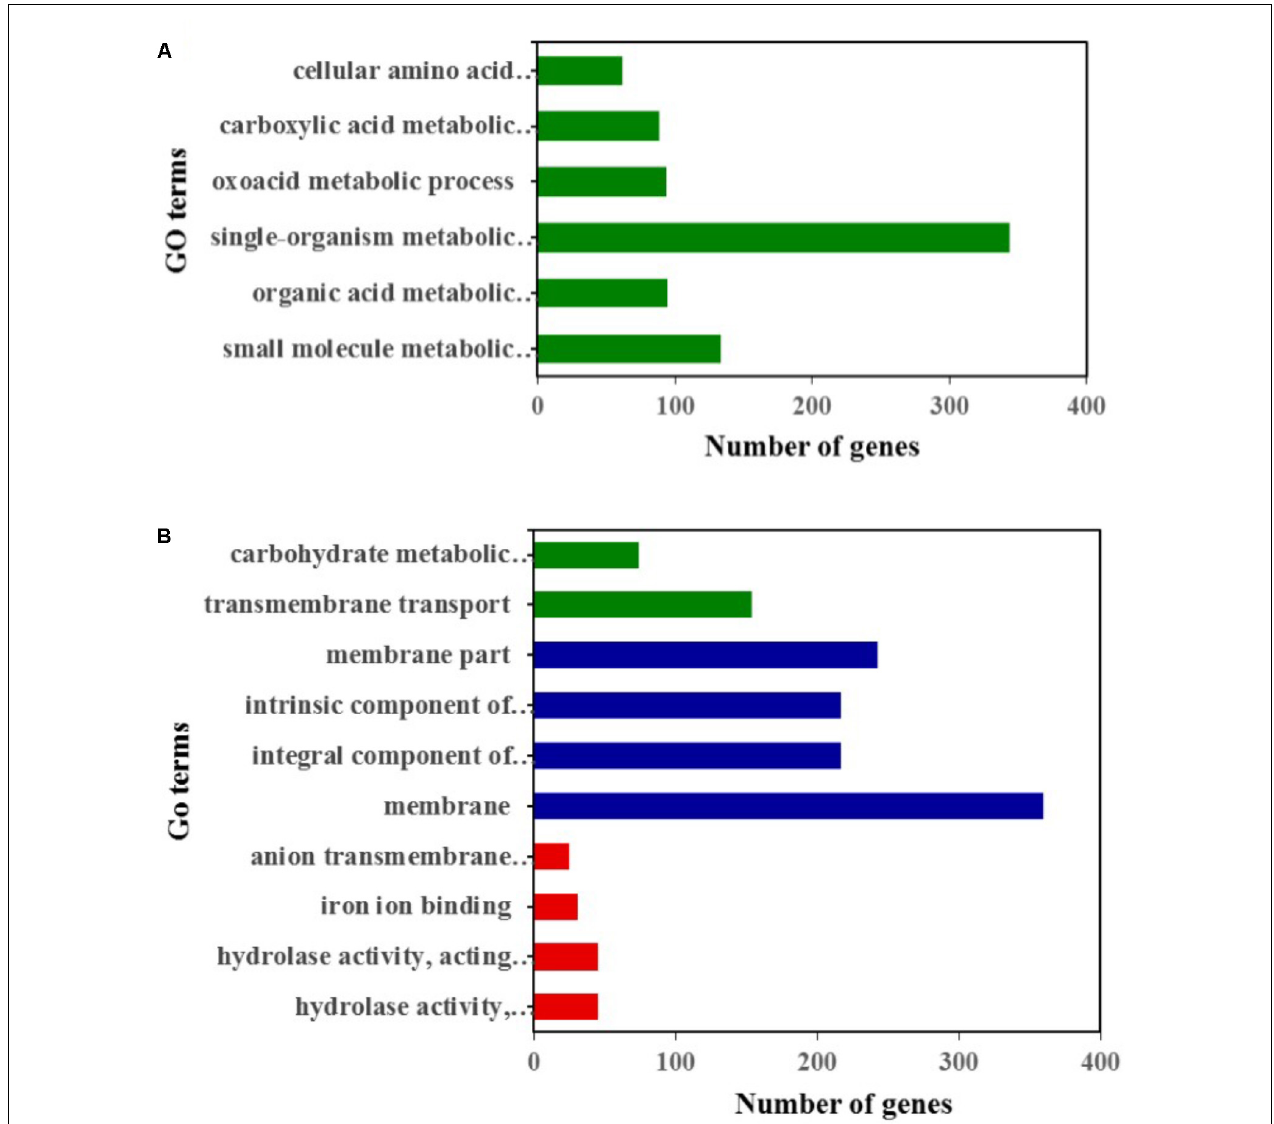
FIGURE 3 | GO classification analysis of genes with significantly upregulated (A) and downregulated (B) expression levels in the winter strain compared to those in the YY-1 strain. Green, blue, and red represent biological processes, cellular components, and molecular functions,